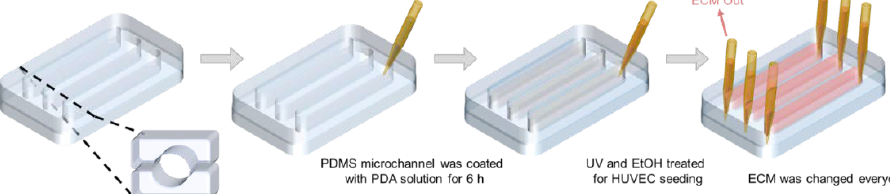
Figure 2. Schematic illustrations showing ( a ) the fabrication process of a cylindrical PDMS microchannel and ( b ) the PDA coating process followed by HUVEC culture.